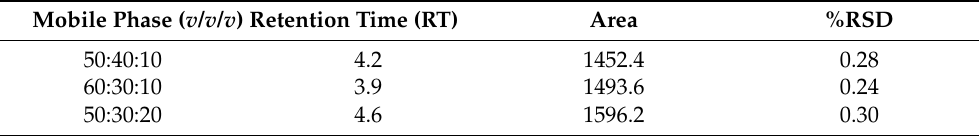
Table 4. Robustness with varied mobile phase ratios (AKH Conc: 100 µ g/mL).